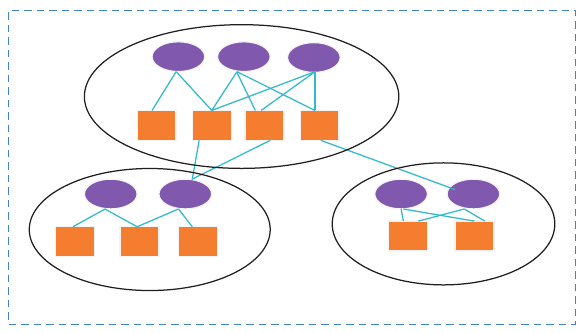
Figure 1: A bipartite network having three